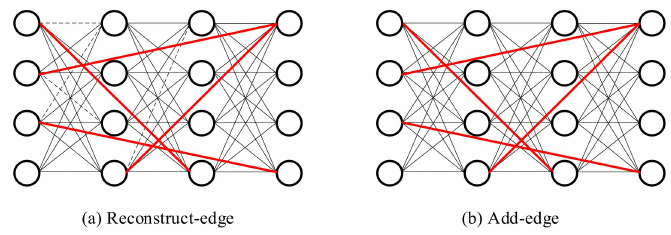
Figure 3. The ways of small-world